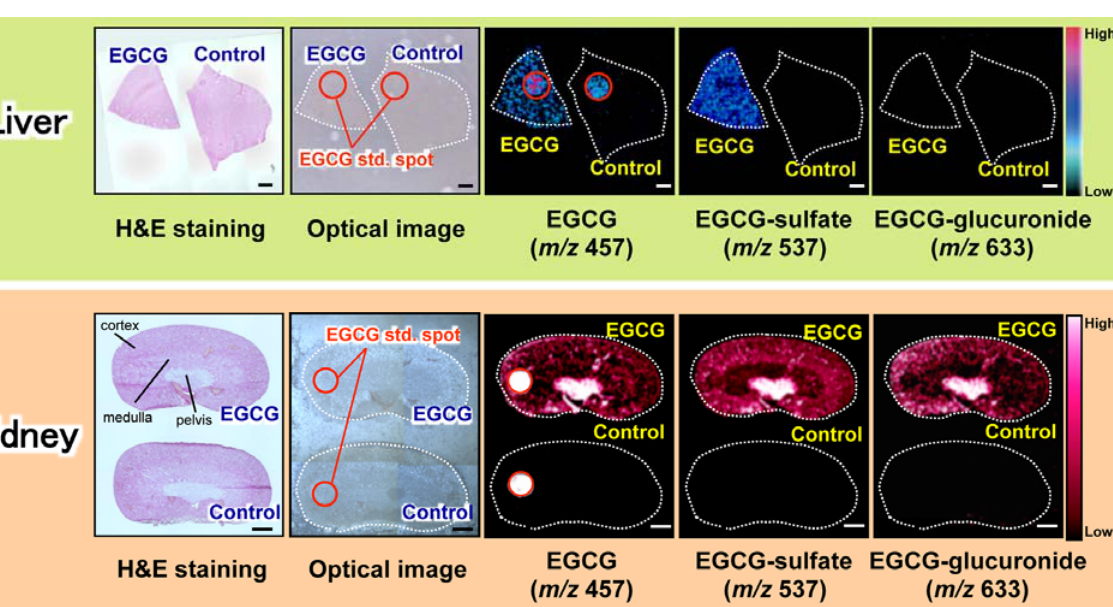
Figure 4. Visualization of dosed EGCG and its phase II metabolites in tissue micro-regions. Simultaneous visualization of EGCG and its phase II metabolites in liver (upper panel) and kidney (lower panel) sections. Three different images are shown in hematoxylin and eosin (H and E) staining, optical microscopy, and MALDI-TOF-MS: EGCG ( m/z 457), EGCG-monosulfate ( m/z 537), and EGCG-monoglucuronide ( m/z 633). An additional EGCG spot (red circle) was visualized as the positive and internal control. Adapted with permission from